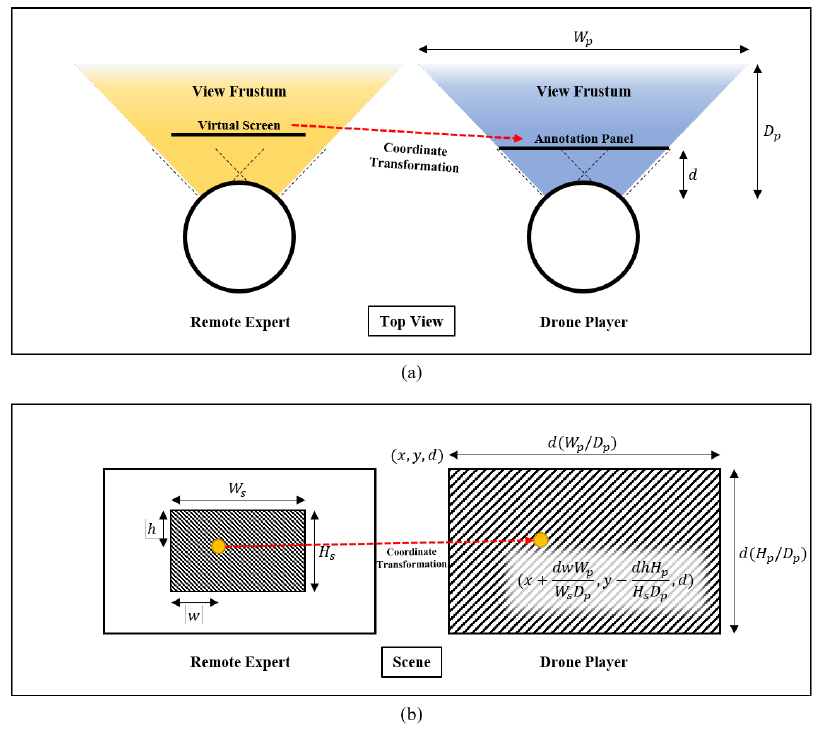
Figure 21. Coordinate transformation of dot annotation considering the field of view frustum of the remote expert. ( a ) From top view ( b ) From players